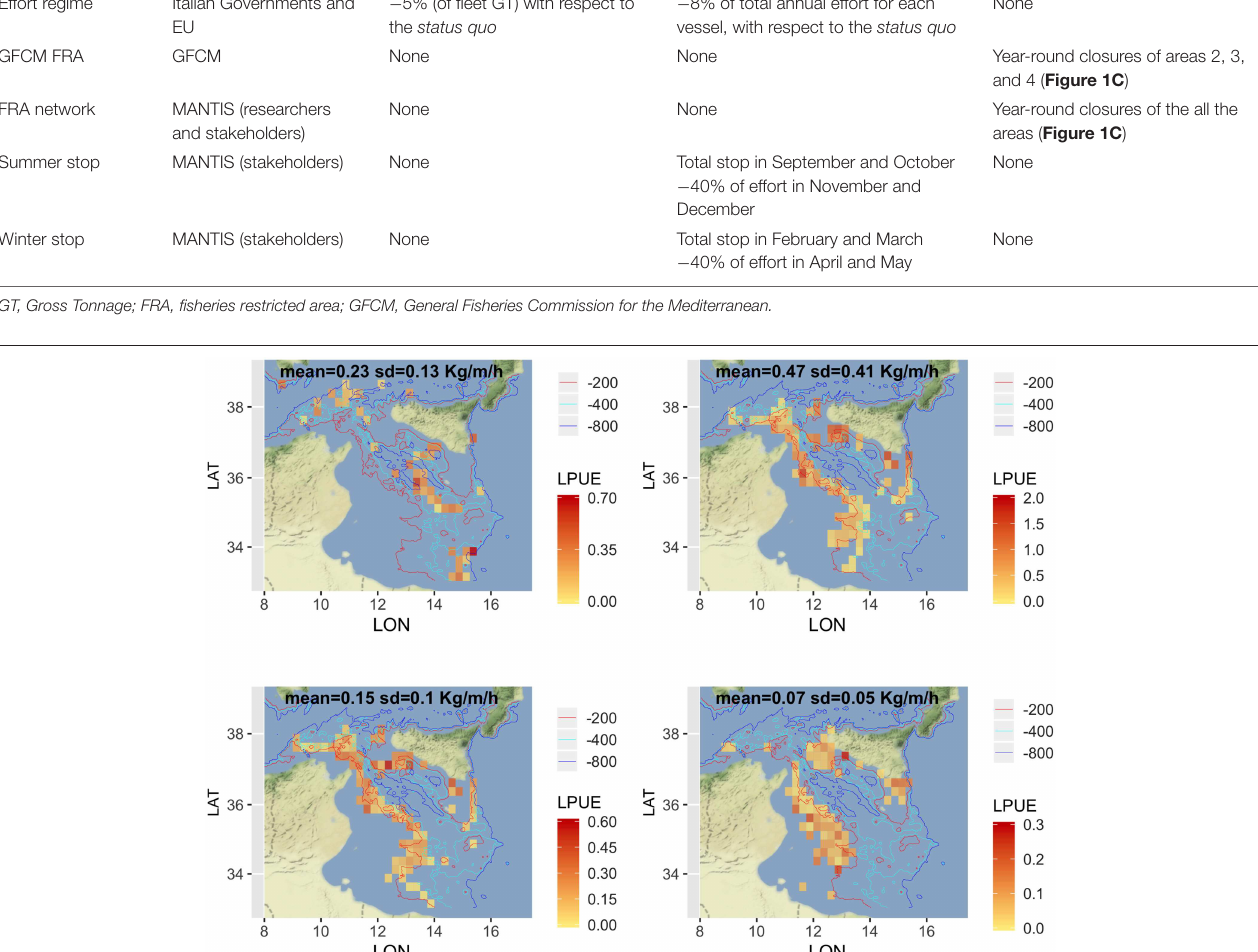
HKE (0.6 kg/m/h), and MUT (0.3 kg/m/h). The main fishing grounds of ARS were distributed offshore in the central region